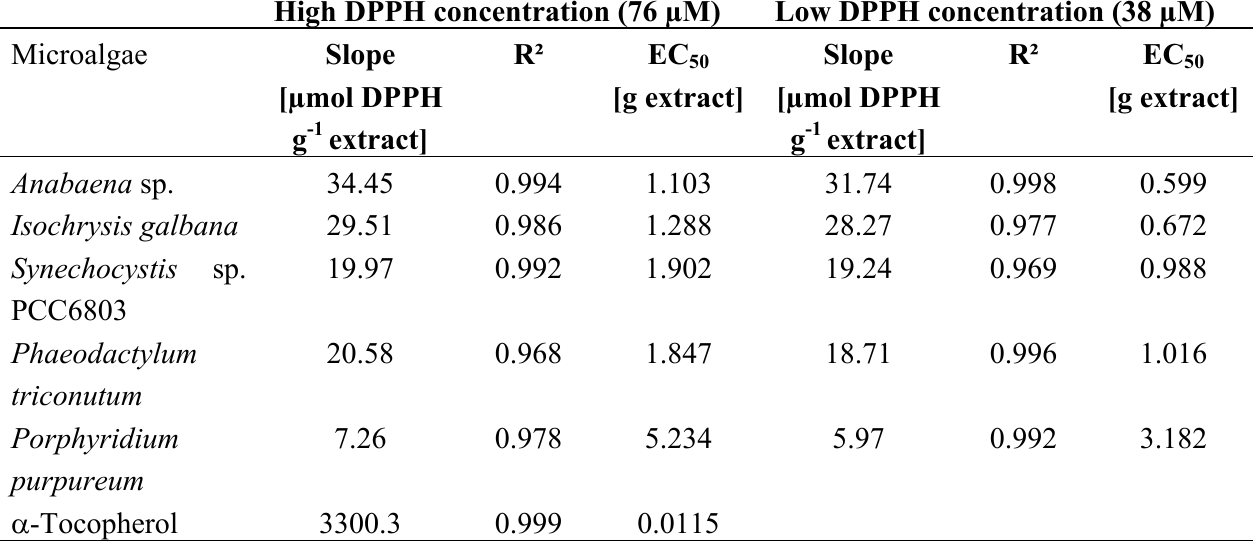
Figure 5. Absorbance decrease of the DPPH radical measured at 550 nm after adding (cid:31) α -tocopherol to extracts of Isochrysis galbana . The reference cuvette is filled with the same extract concentration as in the measuring cuvette. Open circles represent the data for using the low DPPH concentration (38 µmol L -1 ). Closed circles represent the data for using the high DPPH concentration (76 µmol L -1 ). Table 1. Comparison of the slopes of the absorbance measurements, correlation coefficients and values of the different microalgae calculated EC 50